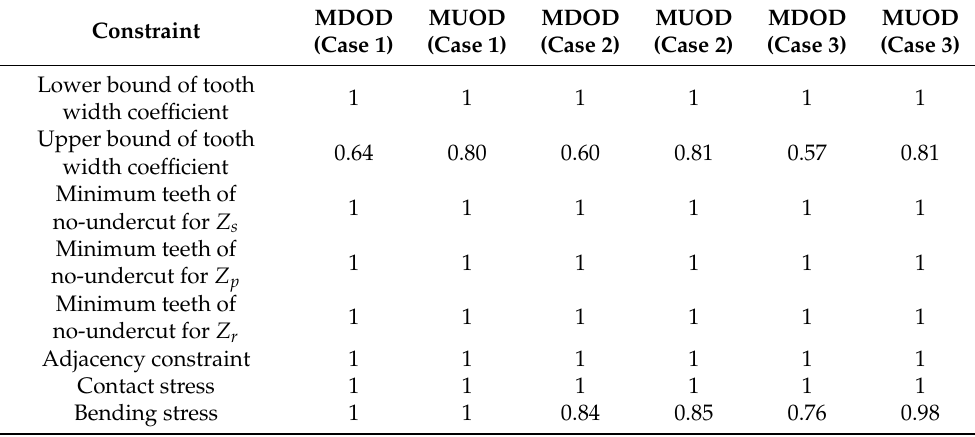
Table 4. Reliability-based possibility degree λ of four solution sets under three uncertainty